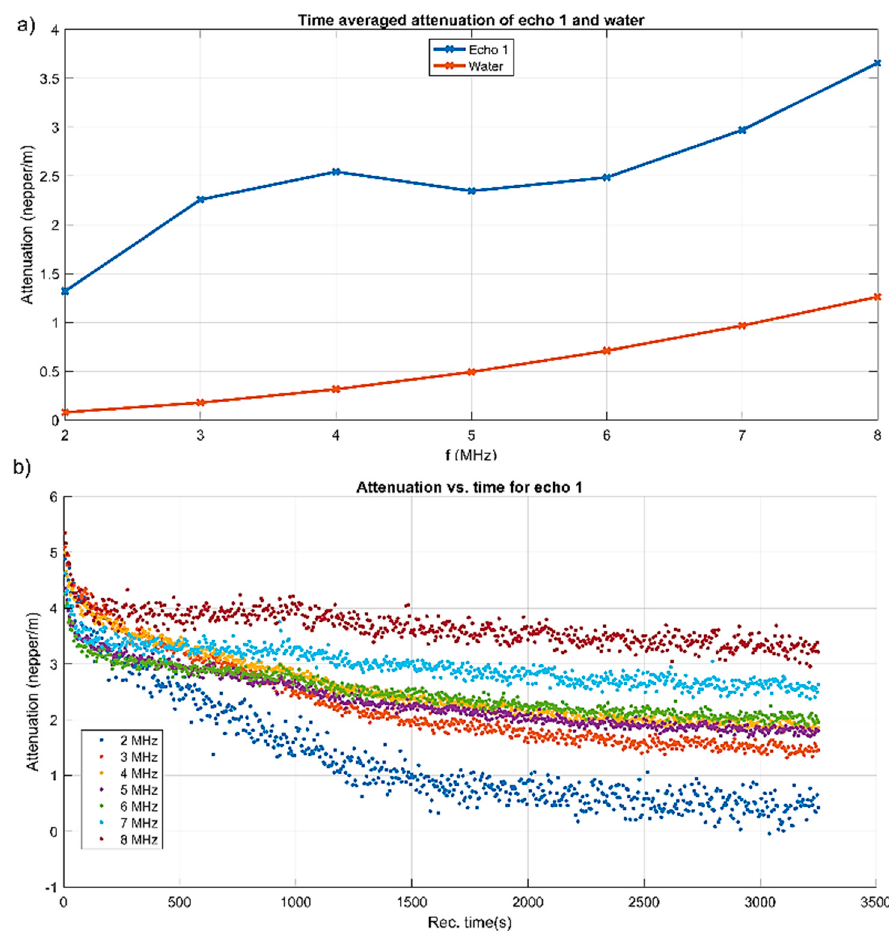
Figure 4. Attenuation vs. frequency for the first transmitted echo ( a ) and attenuation vs. time for the spectral components of echo 1 ( b ).